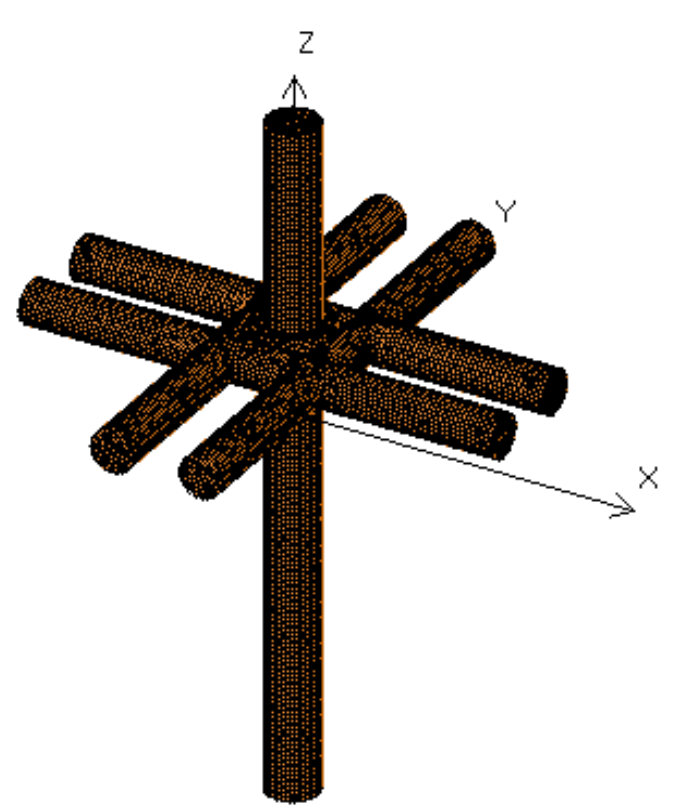
Figure 4. Finite element model of floating platform.